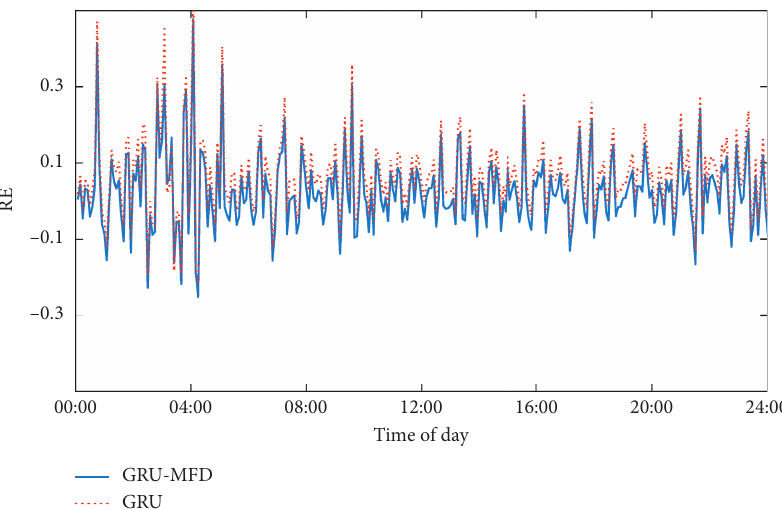
Figure 21: Errors on July 11, 2018, Section